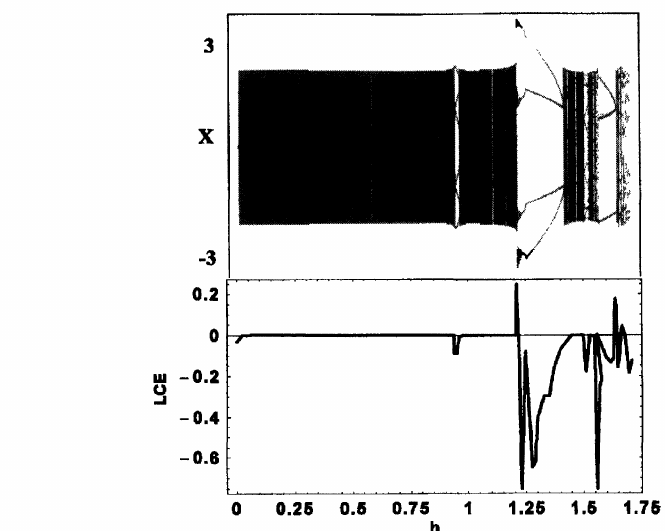
FIGURE 4 Largest Lyapunov characteristic exponent and bifurcation plots as a function of the step size of the nonstandard backward Euler scheme used to integrate the Van der Pol oscillator (2) for 0.1. Expected limit cycle and a mostly instability-free dynamics is sustained for an extended range of steps, about h*